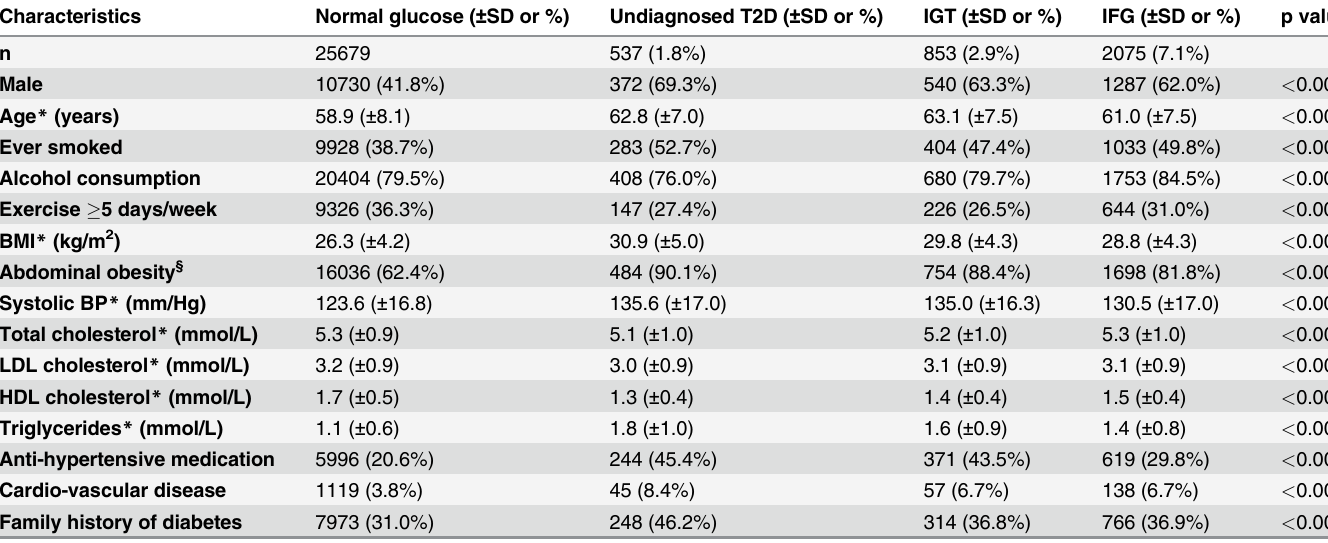
Table 2. DMVhi study participant characteristics by glucose tolerance status (n =